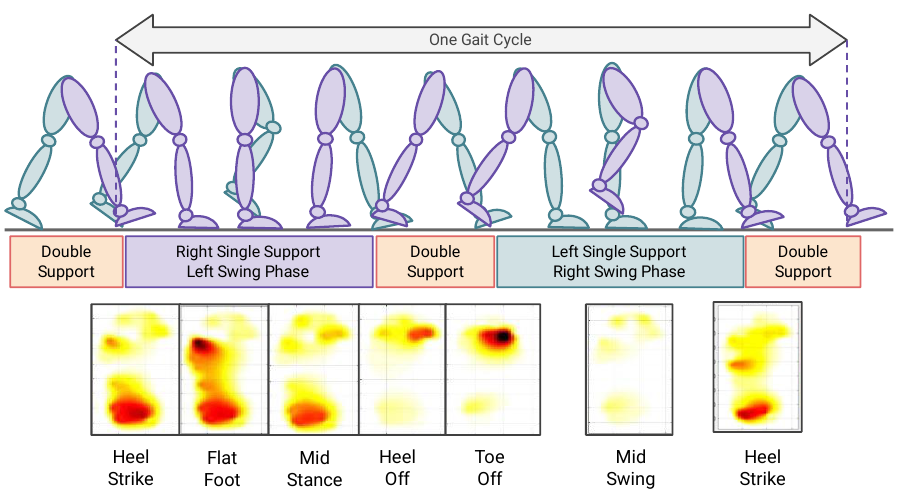
Figure 15. Pressure Map during different phases of the Gait Cycle.